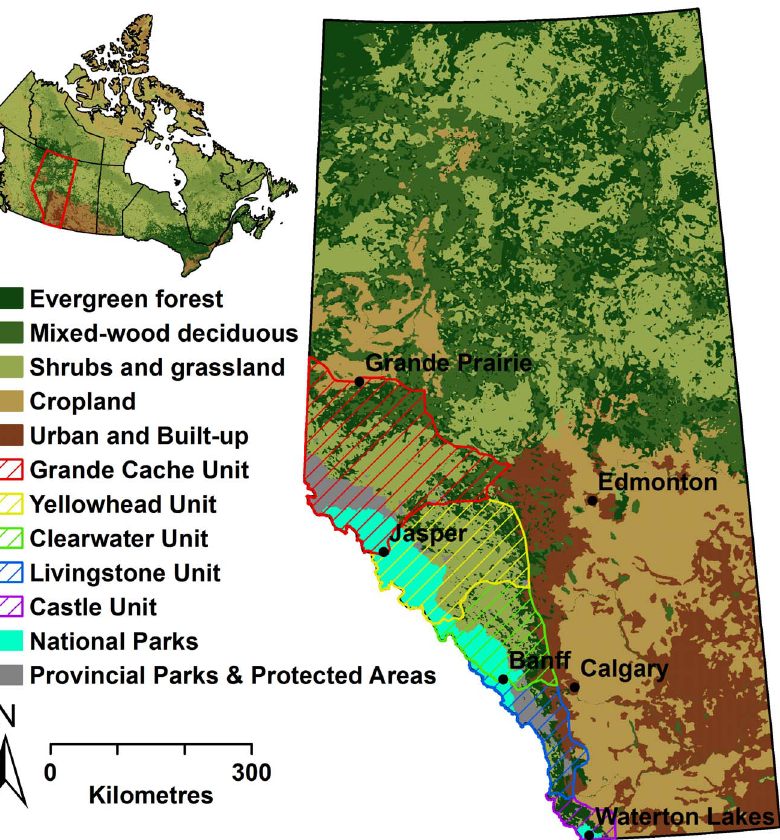
Figure 1. Study area location in Alberta, Canada. Grizzly bear hair samples were collected in each bear management unit during a single summer (Yellowhead – 2004; Clearwater – 2005; Livingstone – 2006; Castle – 2007; Grande Cache – 2008).